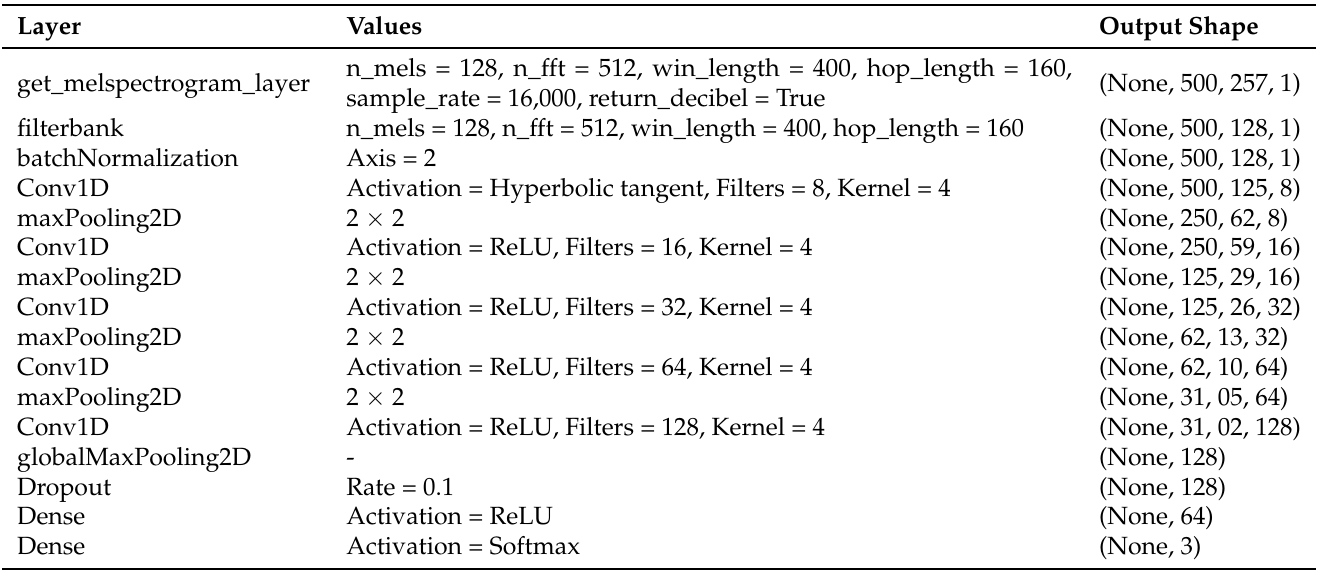
Table 12. Layers detail of Conv1D model.